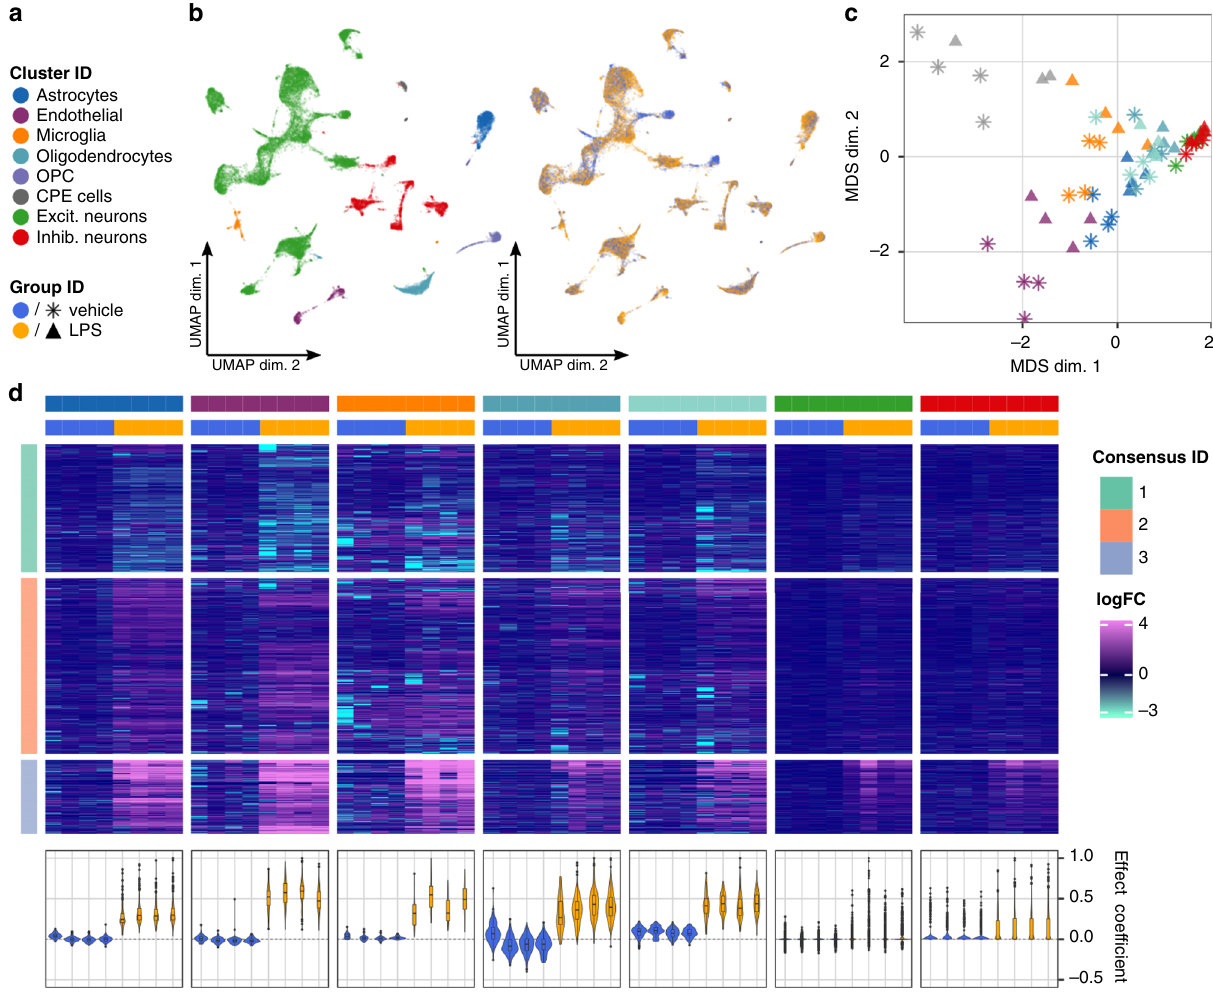
Fig. 4 DS analysis of cortex tissue from vehicle- and LPS-treated mice. a Shared color and shape legend of subpopulation and group IDs. b UMAP visualization colored by subpopulation (left) and group ID (right). c Pseudobulk-level Multidimensional Scaling (MDS) plot. Each point represents one subpopulation-sample instance; points are colored by subpopulation and shaped by group ID. d Heatmap of pseudobulk-level log-expression values normalized to the mean of vehicle samples; rows correspond to genes, columns to subpopulation-sample combinations. Included is the union of DS detections (FDR < 0.05, ∣ logFC ∣ > 1) across all subpopulations. Data are split horizontally by subpopulation and vertically by consensus clustering ID (of genes); top and bottom 1% logFC quantiles were truncated for visualization. Bottom-row violin plots represent cell-level effect coef fi cients computed across all differential genes, and scaled to a maximum absolute value of 1 (each violin is a sample; coloring corresponds to group ID); effect coef fi cients summarize the extent to which each cell re fl ects the population-level fold-changes (see “ Methods ”